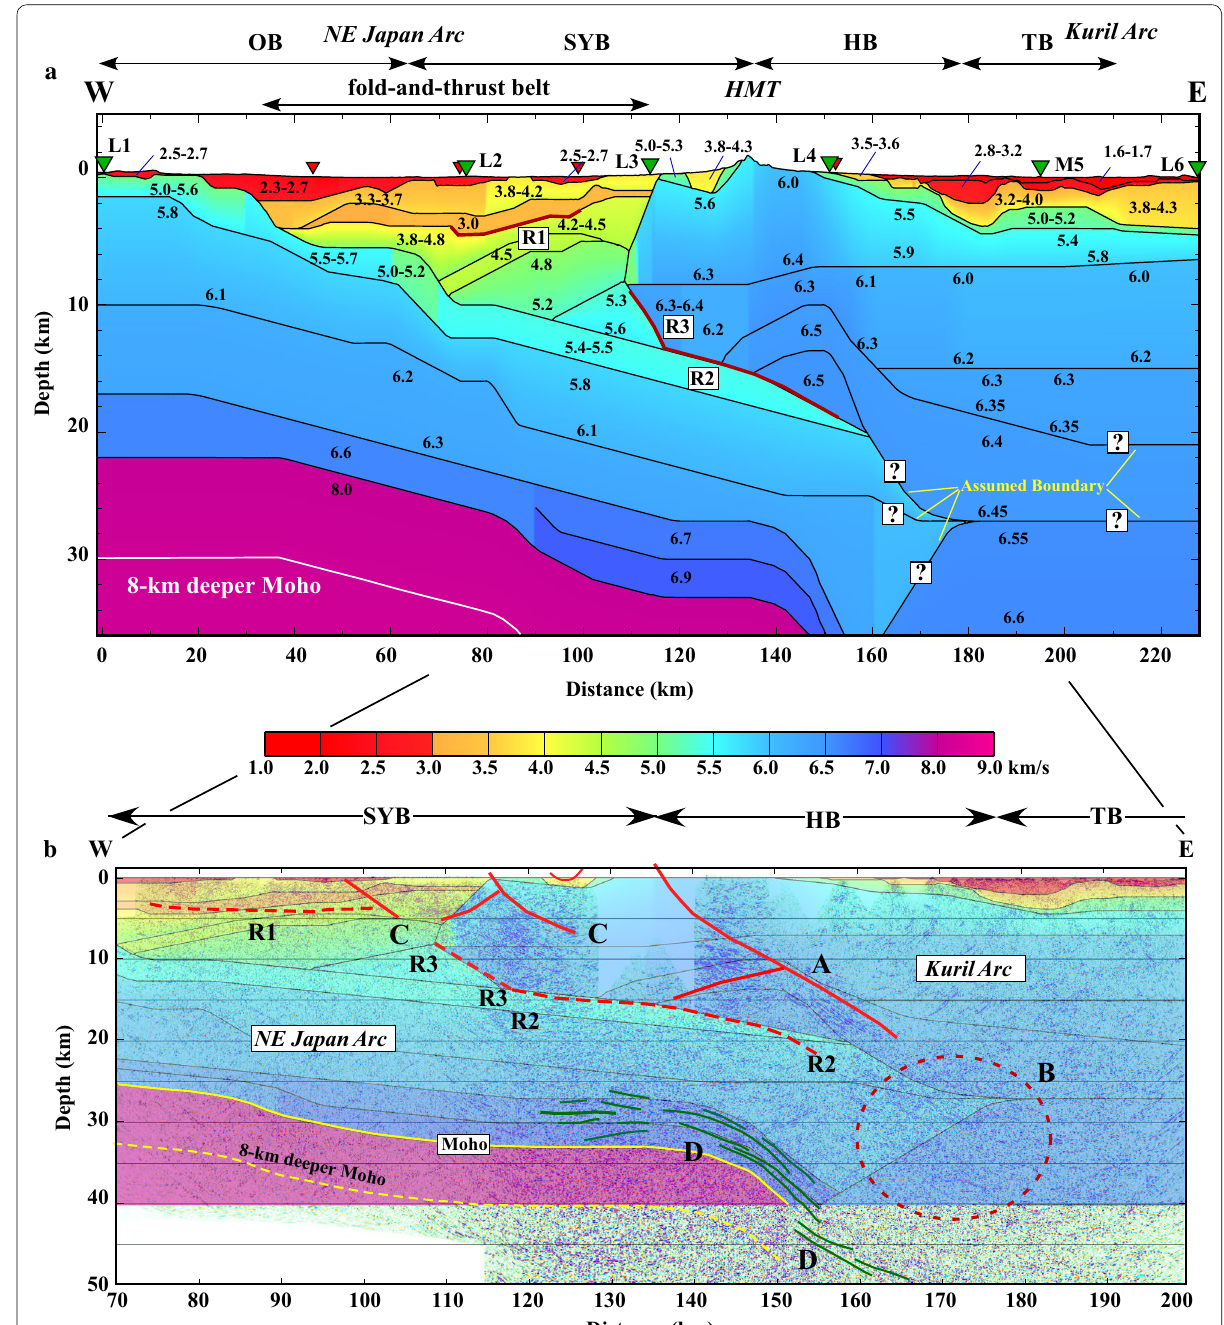
Fig. 5 Velocity structure model by ray-tracing technique. a Entire velocity structure model. The shallower part (< 15–20-km depth) is based on the model by Iwasaki et al. (2004). Thick brown lines of “R1” to “R3” are layer boundaries well correlated with the seismic reflection image in Fig. 2c. Shot positions used in the forward analysis are indicated by triangles. A white line is the location of the 8-km deeper Moho (see the text for explanation). b Direct comparison of velocity model with seismic reflection image. The velocity model in a is superimposed on the depth-migrated section in Fig. 2c with the same notations and